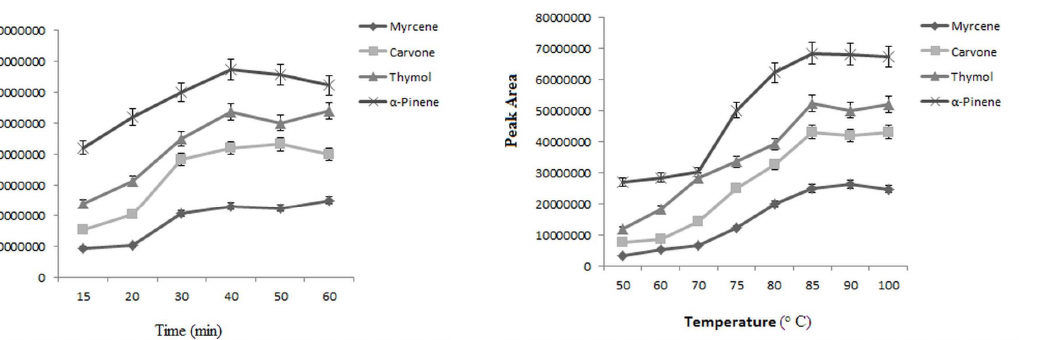
Fig. 2. Effect of extraction temperature on extraction efficiency.